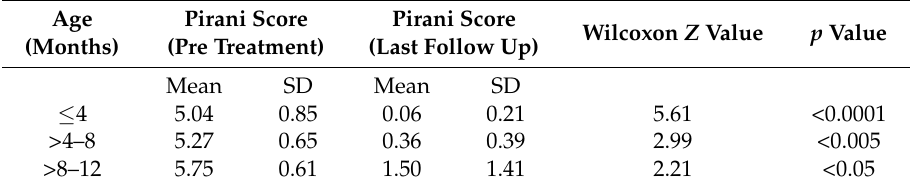
Table 2. Pirani score distribution pre- and post-treatment.